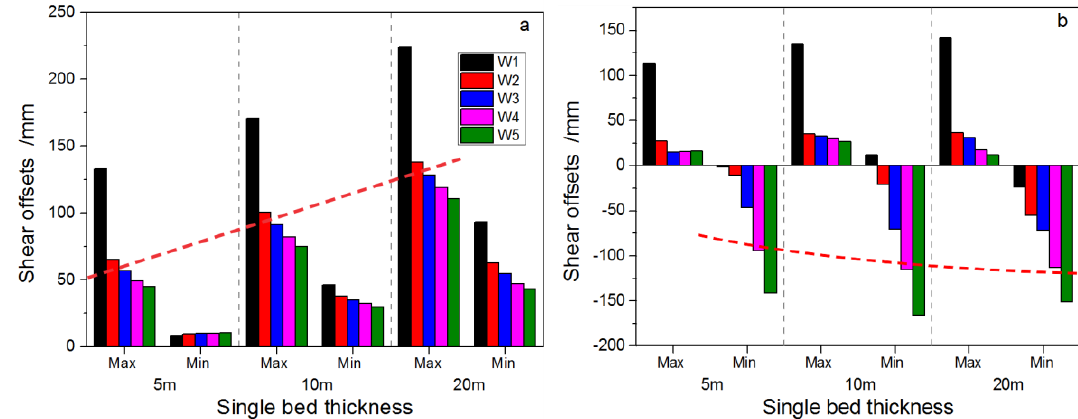
Figure 3. Extreme value statistics of horizontal shear offsets of hydrocarbon wells after the ( a ) first panel is removed and then ( b ) twin panels are removed sequentially in the cases of various SRLTs.